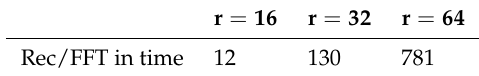
Table 2. Example 2: Relative performances of the two methods when varying r ( θ = 7/ r ). r = 16